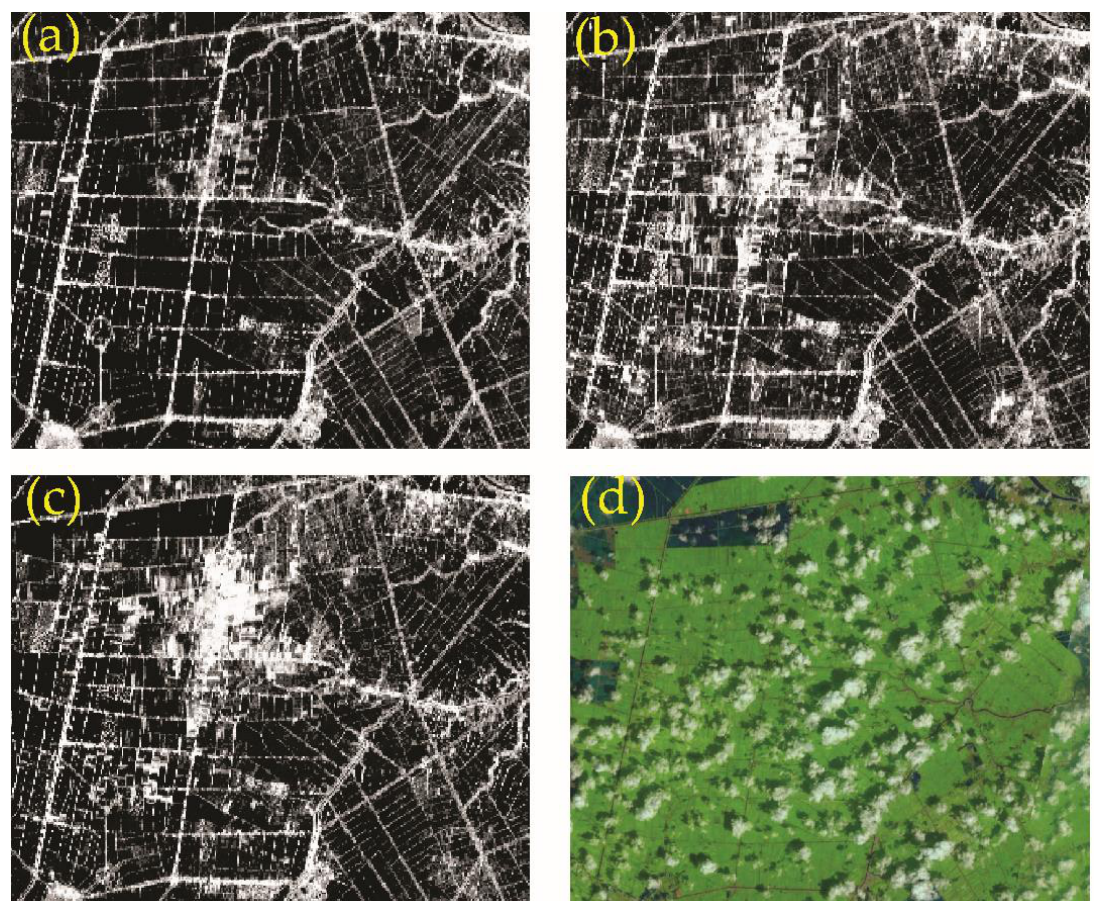
Figure 10. Seasonal dynamics of ALOS-2/PALSAR-2-ScanSAR data’s HH microwave backscattering coefficient (( a ) 10 April, ( b ) 3 July, and ( c ) 23 October) showing an area of the Mekong Delta enclosed with the yellow box shown in Figure 9. The data obtained on 23 October 2015 (c) are compared with the spatially consistent data of LANDSAT-8 on 30 October 2015 ( d ).